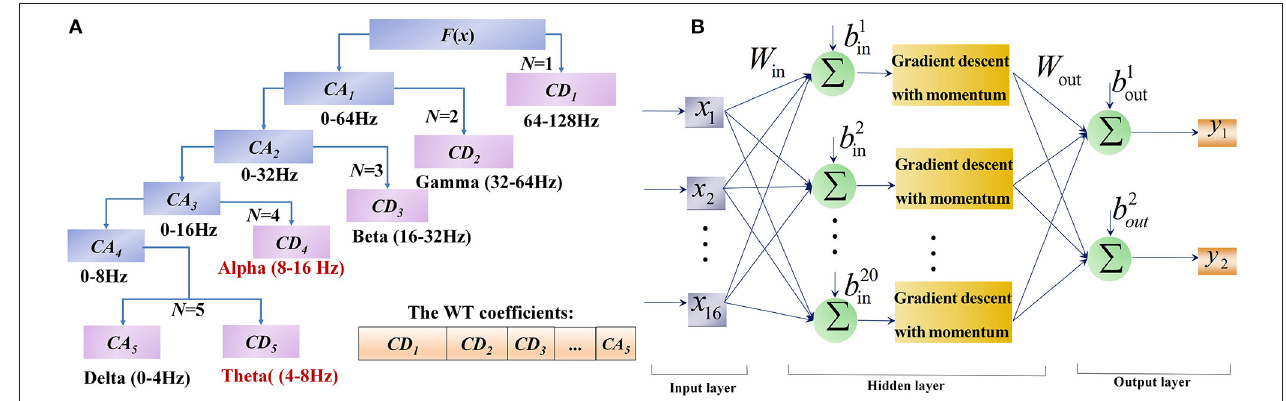
FIGURE 3 | The flowcharts of WT and BPNN in FE-BCI system. (A) The flowchart of WT by 5 level decomposition. (B) The flowchart of BPNN with 3 layers and 20 nodes of hidden layer.